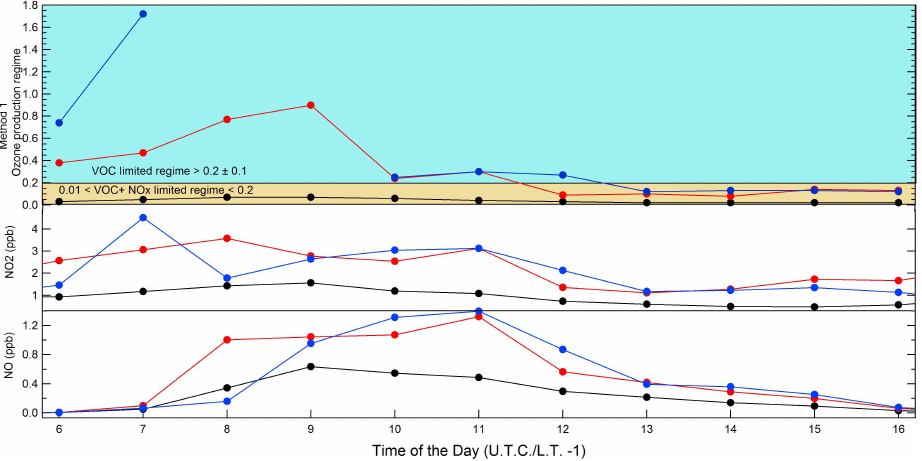
Fig. 4. Average diurnal profiles of the hydroxyl radical (OH), hydroperoxy radical (HO 2 ), sum of peroxy radicals (RO ∗ (HCHO) and sulphur dioxide (SO 2 ) in air masses from the continental, huelva and ocean wind sectors.